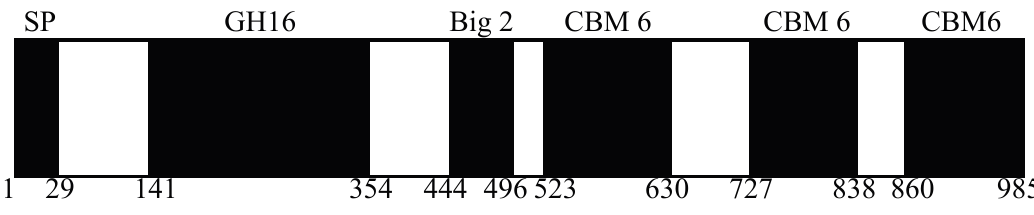
Figure 1. Predicted domain structure of AgaA from P. vesicularis MA103. SP, signal peptide; GH16, glycoside hydrolase module of family 16; Big-2, bacterial immunoglobulin group 2 domain; CBM 6, carbohydrate-binding module 6. The amino acid residues of each domain are indicated below the